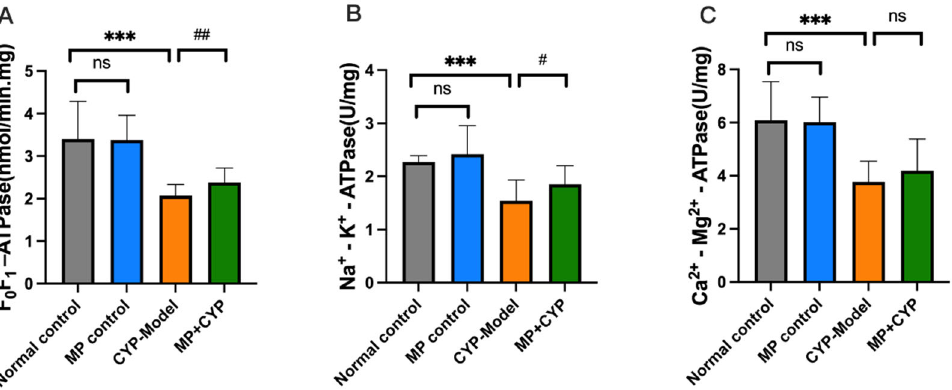
Figure 6. Effect of Maca polysaccharide on enzyme content of energy metabolism in liver tissue of CYP-treated mice ( n = 12). ( A ) F 0 F 1 -ATPase; ( B ) Na + -K + -ATPase; ( C ) Ca 2+ -Mg 2+ -ATPase. *** p < 0.0001 compared with Normal Control group; # p < 0.05, ## p < 0.01 compared with CYP Model group. Data are expressed as means ± SEM.